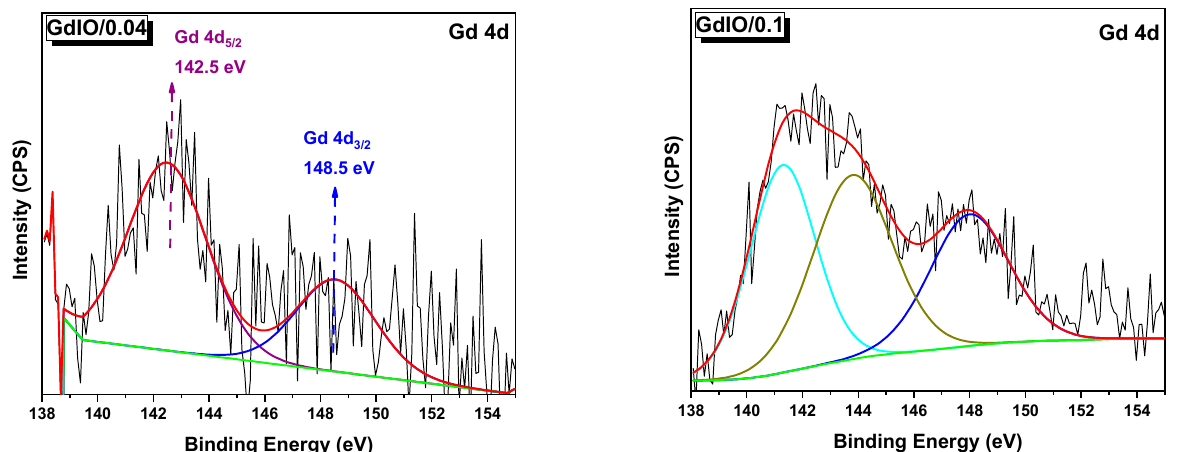
Figure 5. High resolution XPS plots showing the peaks for gadolinium ions for samples Gd IO/0.04 ( left ) and Gd IO/0.1 ( right ).